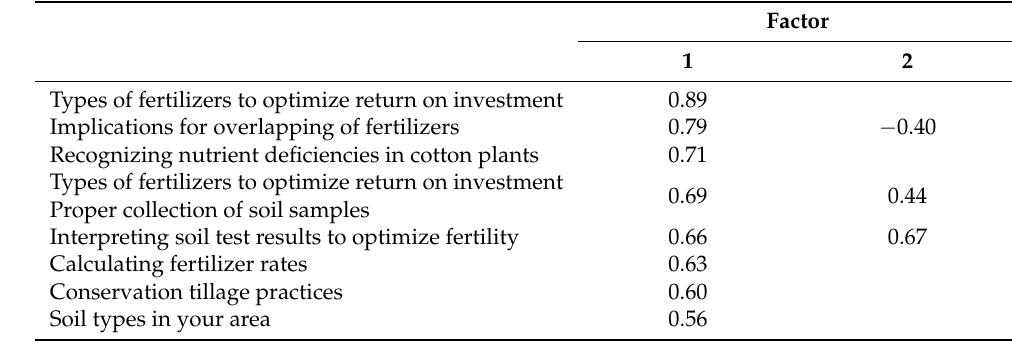
Table 10. Factor loadings and importance items of soil and nutrient management competencies.